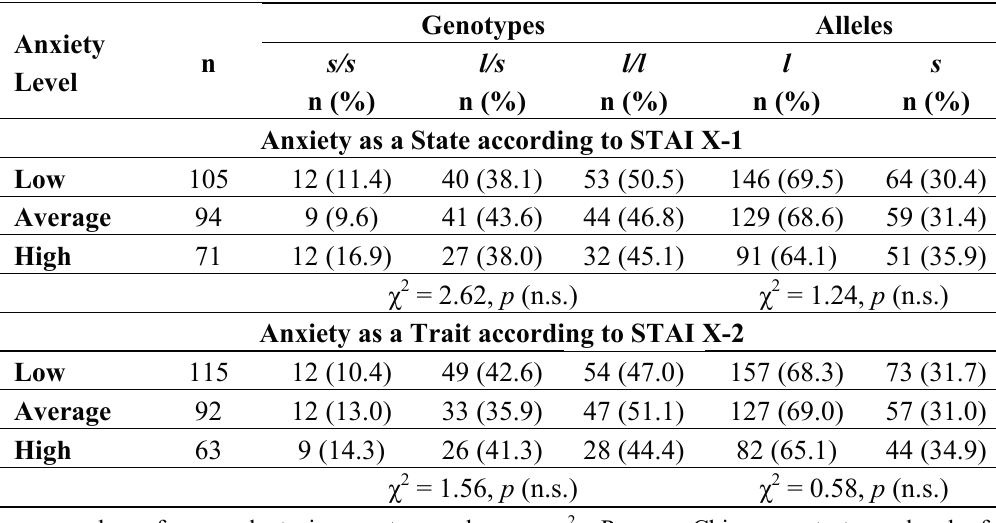
Table 2. Distribution of genotypes and alleles frequency of the polymorphism in the 5-HTTLPR (SLC6A4) promoter region, and intensity of anxiety as a state acc. to STAI X-1 and as a trait acc. to STAI X-2.